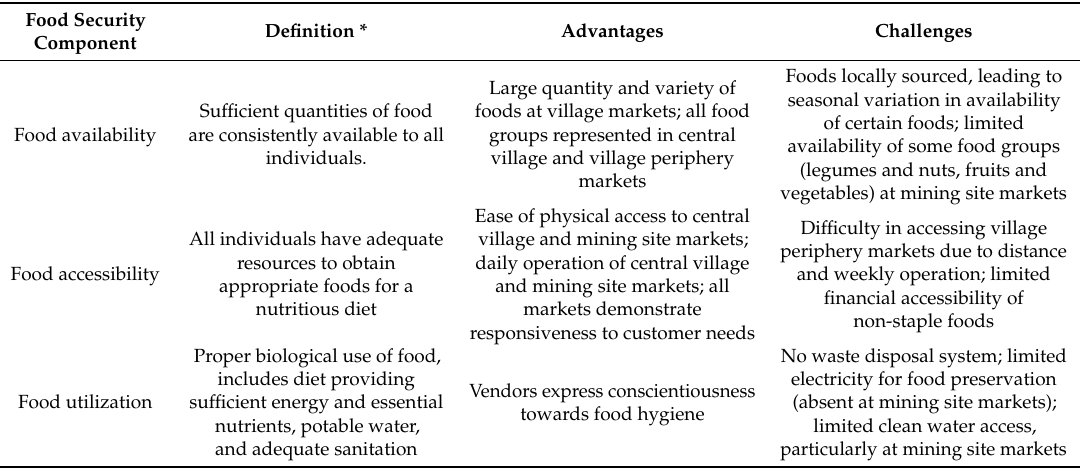
Table 3. Summary of market-related advantages and challenges to ASM food security, organized by food security component.